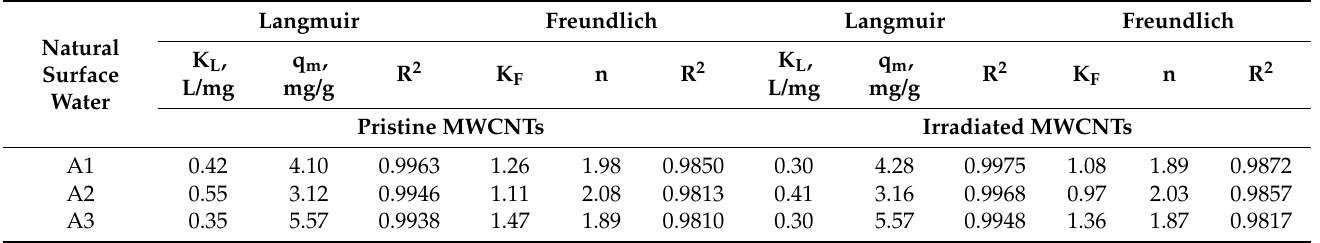
Table 2. Parameters for the adsorption of TCC on MWCTs in natural surface waters at 5 ◦ C. Langmuir Freundlich Langmuir